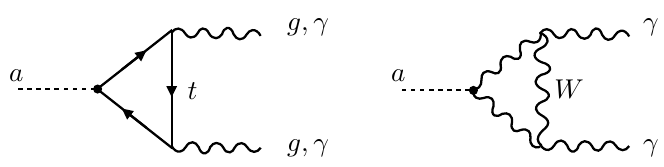
Figure 4 . Examples of one-loop matching contributions to the ALP-boson couplings. These diagrams do not give rise to matching contributions when the form of the effective Lagrangian in (2.1) is